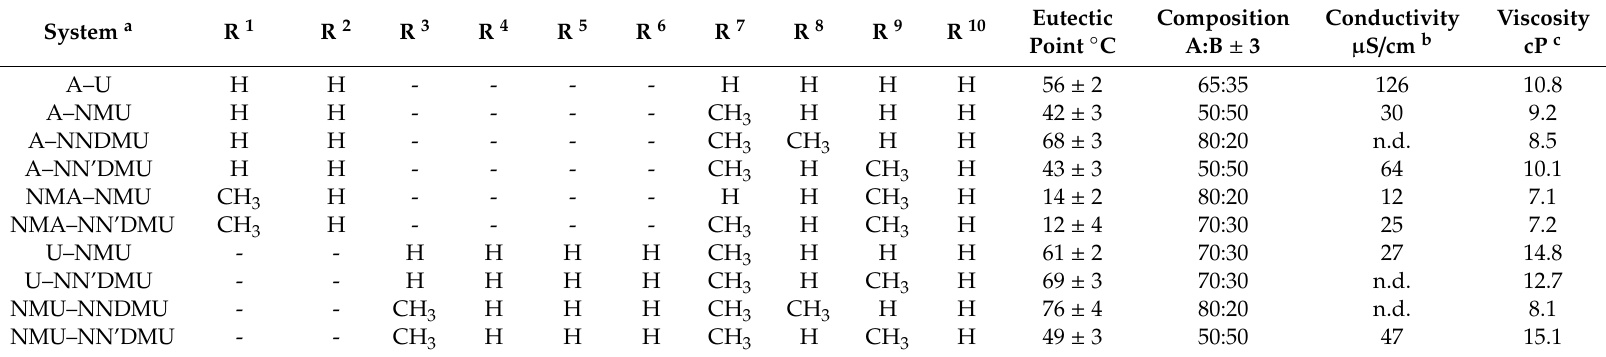
Table 2. Non-ionic deep eutectic mixtures comprised of components A and B where the general structures of A is either R 1 R 2 N-CO-CH 3 or R 3 R 4 N-CO-NR 5 R 6 and that of B R 7 R 8 N-CO-NR 9 R